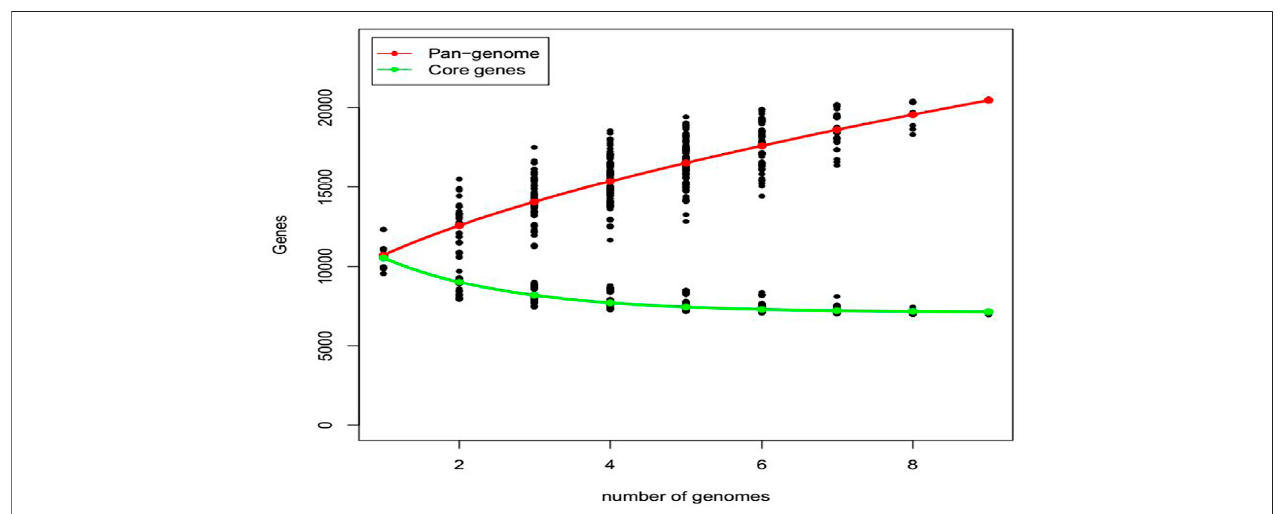
FIGURE 5 | The pan and core genome analysis of eight fungal strains isolated from fi ve different hosts. The red pan-genome curve represents the total number of gene families present in the fungal strains. While the core genome is presented by a green curve showing the conserved gene families.